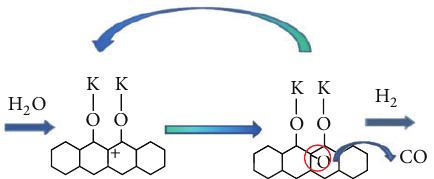
Figure 7: H 2 O–C catalytic reaction schematic